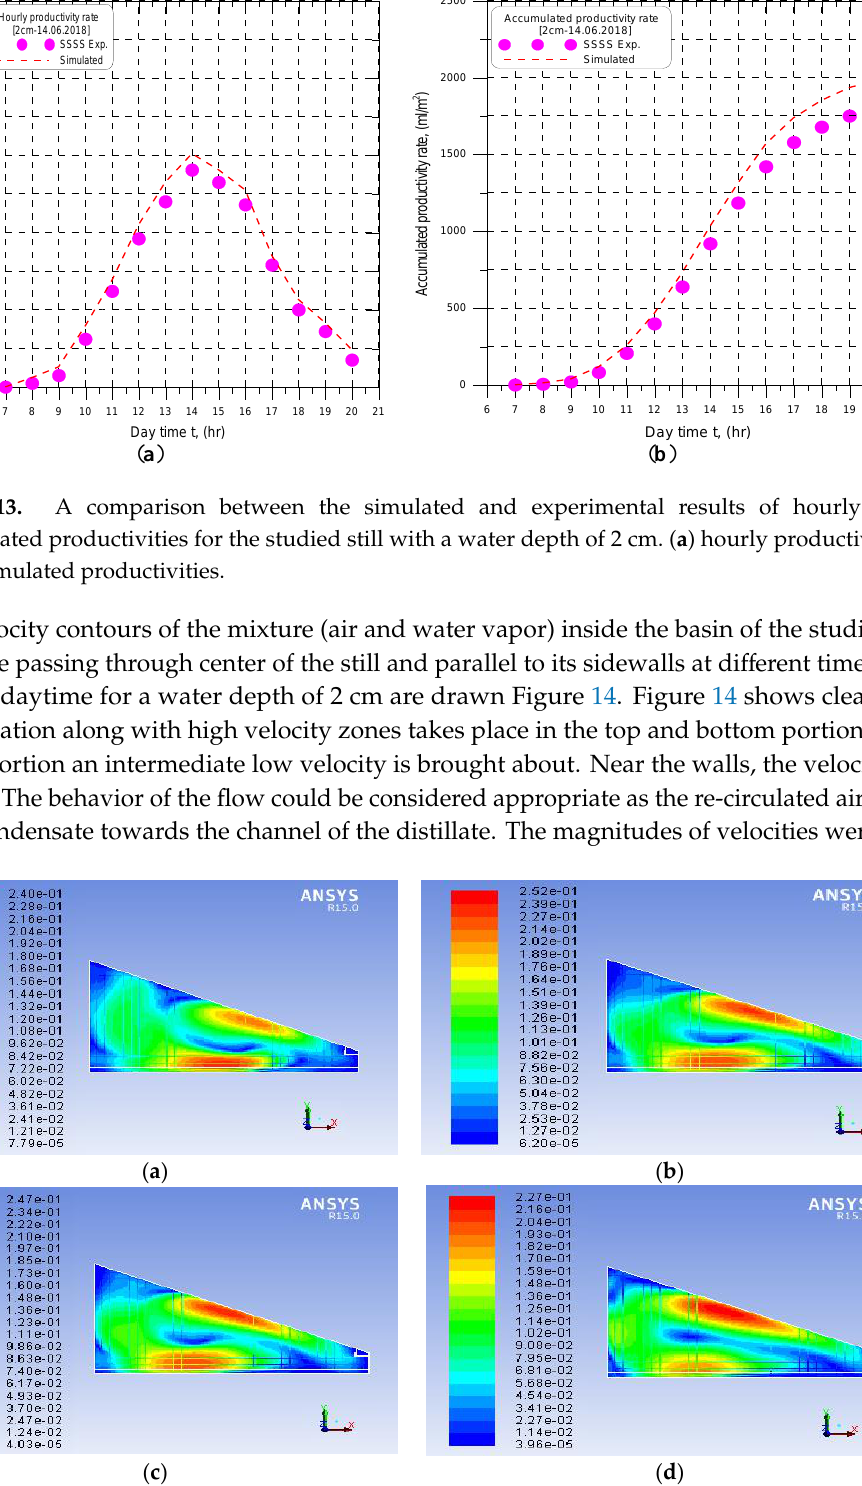
Figure 14. The mixture velocity contours at different times for the studied still with a water depth of 2 cm. ( a ) Velocity contour at 10:00, ( b ) velocity contour at 12:00, ( c ) velocity contour at 14:00, ( d ) velocity contour at 16:00.